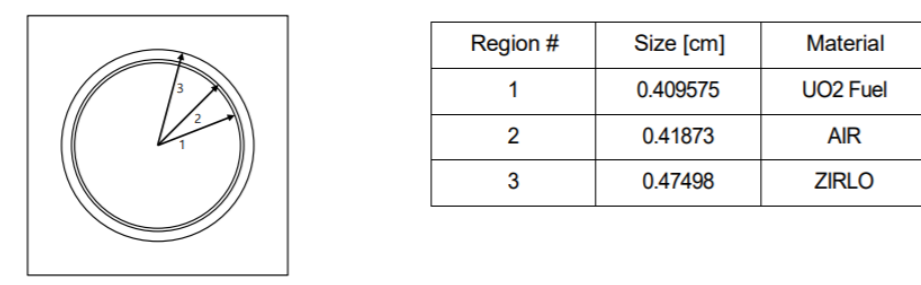
Figure 1. Radial Configuration of Fuel Rod [6].